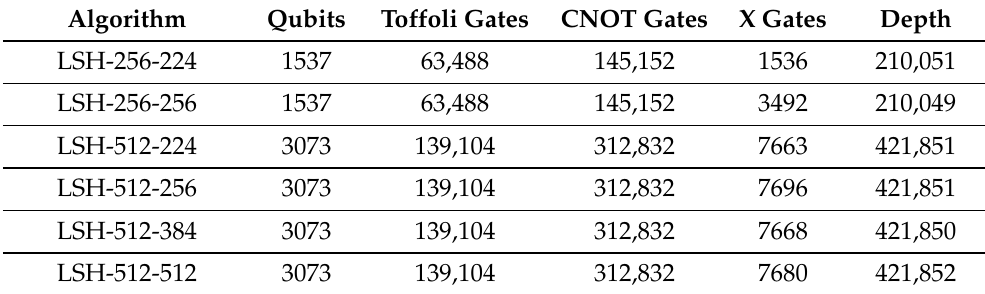
Table 5. Quantum resource estimation results for the sequential LSH quantum circuit proposed in [19].